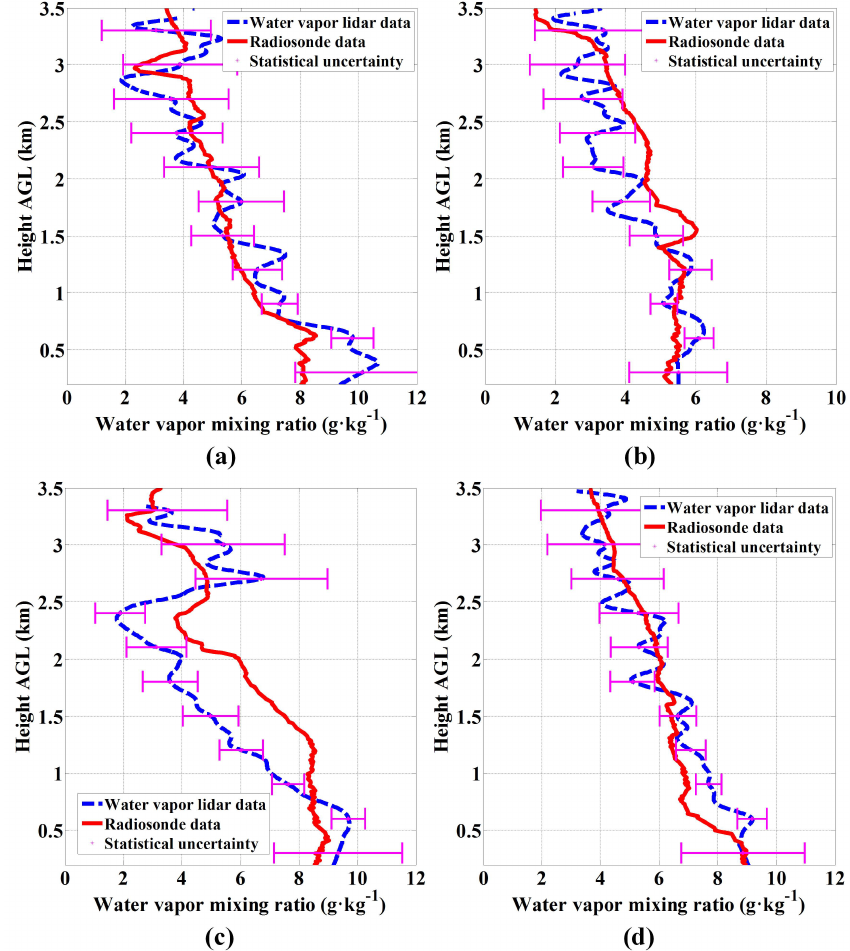
Figure 4. Water vapor mixing ratio case studies: (a) , (b) , (c) and (d) measured in Naqu on 11, 15, 18 and 22 July 2014,